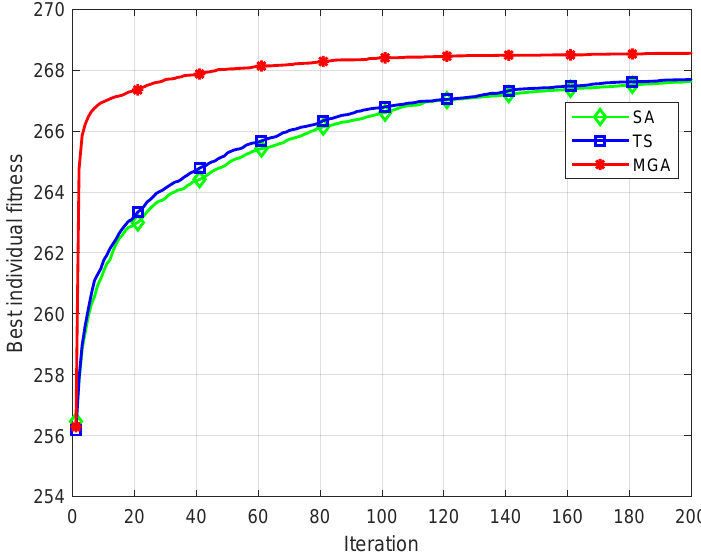
Figure 4. Simulation experimental curve of hill-climbing operator